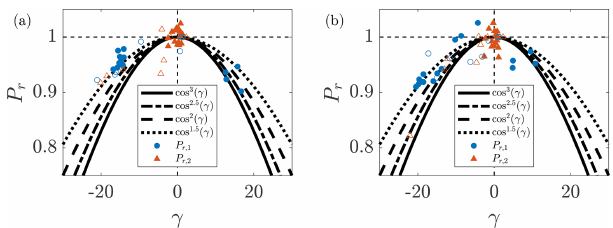
Figure 5. Power ratio Pr = P i /P ref for turbines 1 and 2 (see lay- out in Fig. 1) for (a) Case L open-loop lookup table control and (b) Case D closed-loop control shown as a function of the real- ized yaw misalignment with respect to the hub-height wind direc- tion. Power ratios for stable atmospheric stability (Obukhov length 0 < L < 200) are shown with filled markers, and hollow markers are unstable and stability transition periods. The power ratio is av- eraged for 30min for each sample.